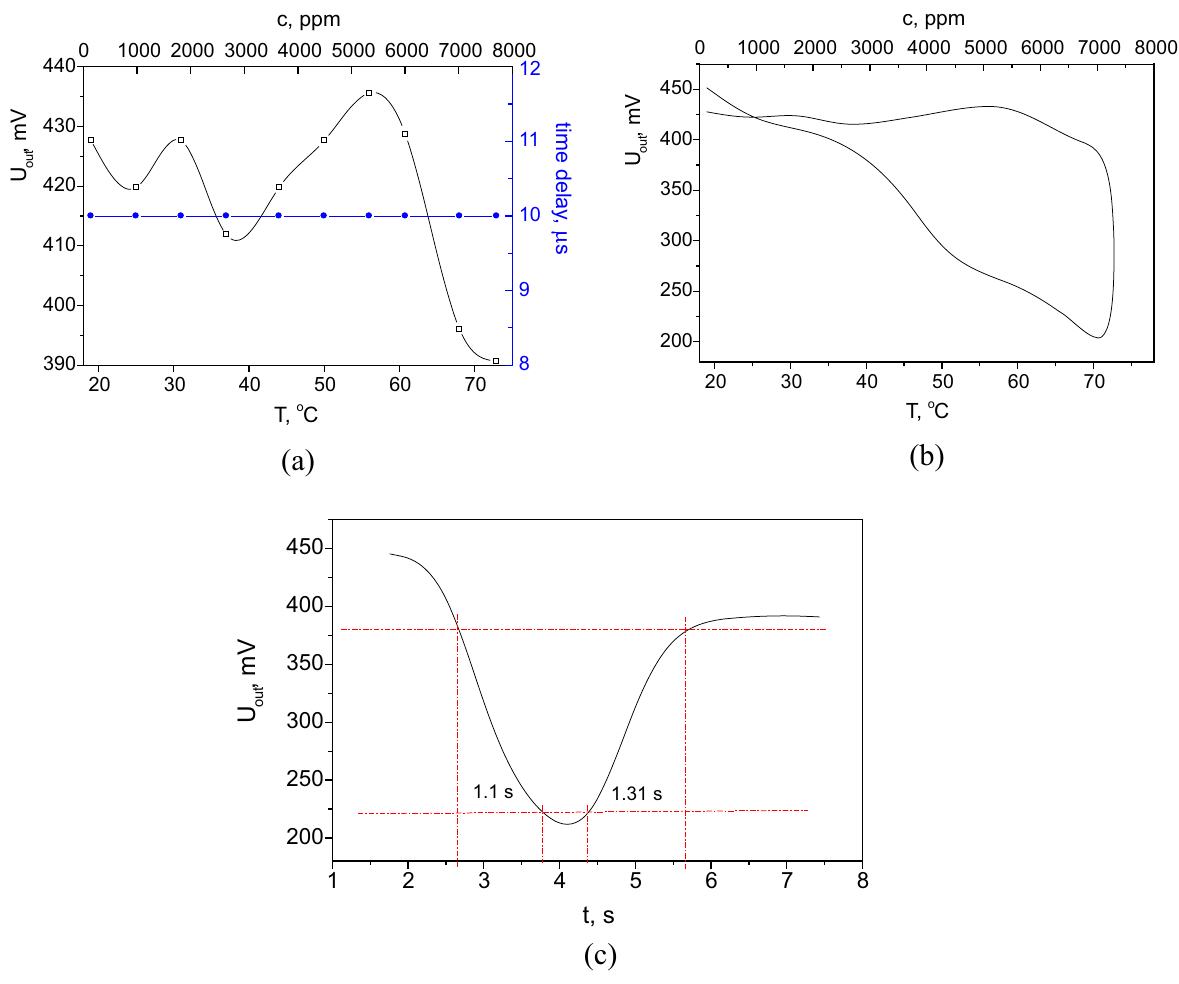
Figure 5: SAW sensor response to ethanol: ( a ) output voltage and time delay between the output and input voltage of IDTs, ( b ) hysteresis, and ( c ) response and recovery times for the non - textured PEDOT:PSS